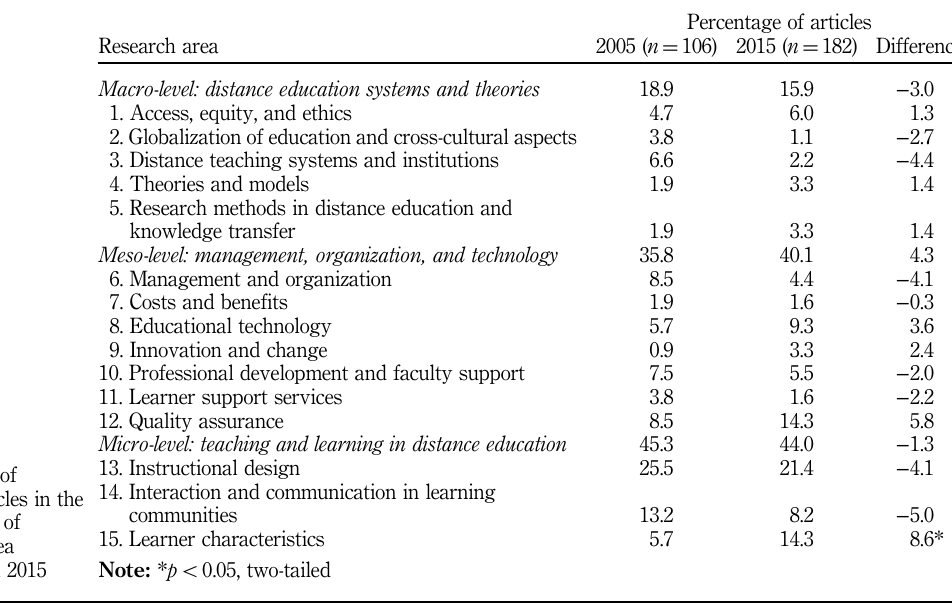
Table I. Percentage of journal articles in the three levels of research area in 2005 and